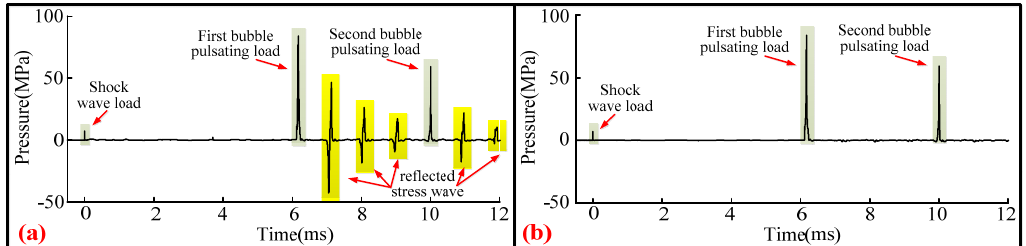
Figure 8. The pressure–time curve measured by the Hopkinson bar. ( a ) The pressure–time curve of the complete signal measured by the Hopkinson bar and ( b ) the optimized reflected stress wave signal, leaving only the pressure–time curve of the incident stress wave signal.